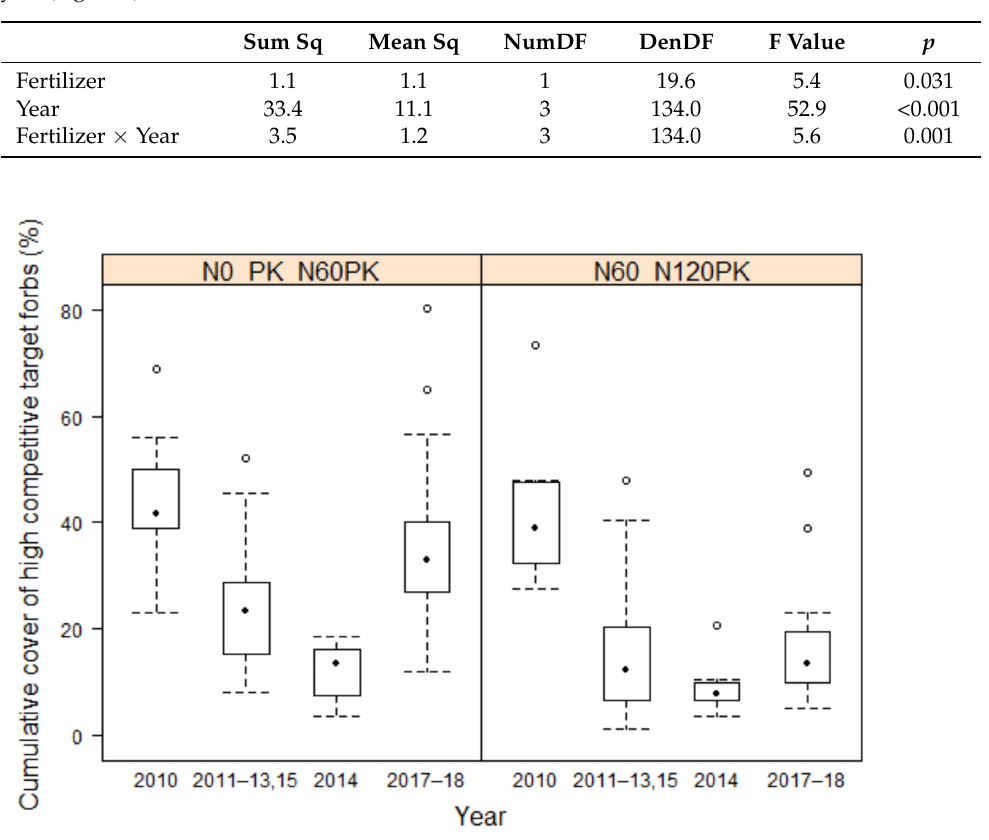
Table 8. Effects of fertilizer and year on the cumulative cover of high-competitive target forbs accord- ing to the minimal adequate model. The model had two levels for the fertilizer and four levels for year (Figure 7).